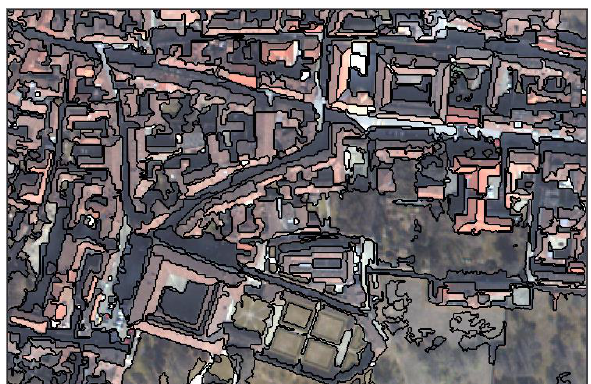
Figure 14. Result of the segmentation on the urban area of the city of